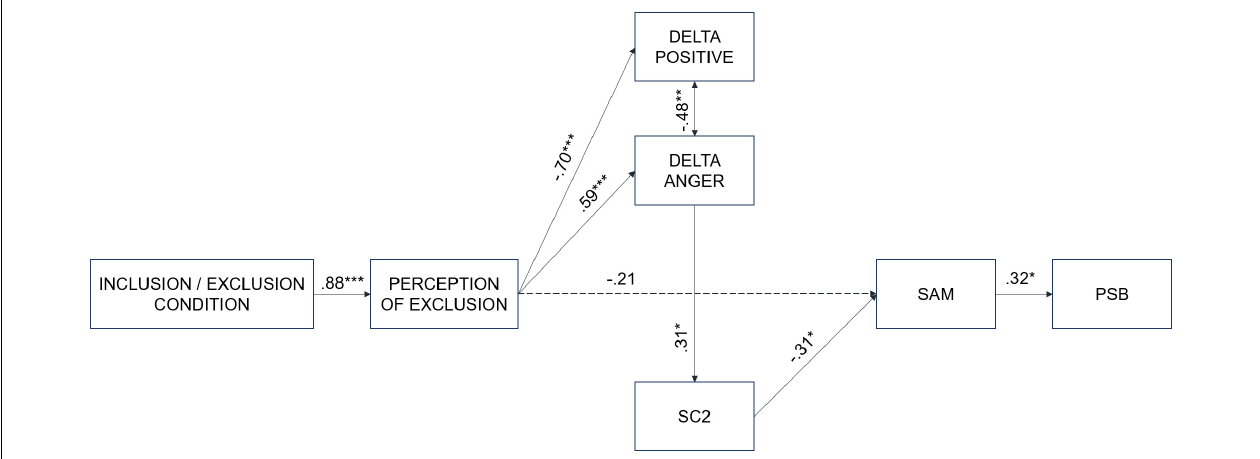
FIGURE 2 | Predictive model of prosocial behavior. SC2 = variation of skin conductance; SAM = social affiliation motivation; PSB = prosocial behavior. * p < 0 . 05; ** p < 0 . 01; *** p < 0 . 001.